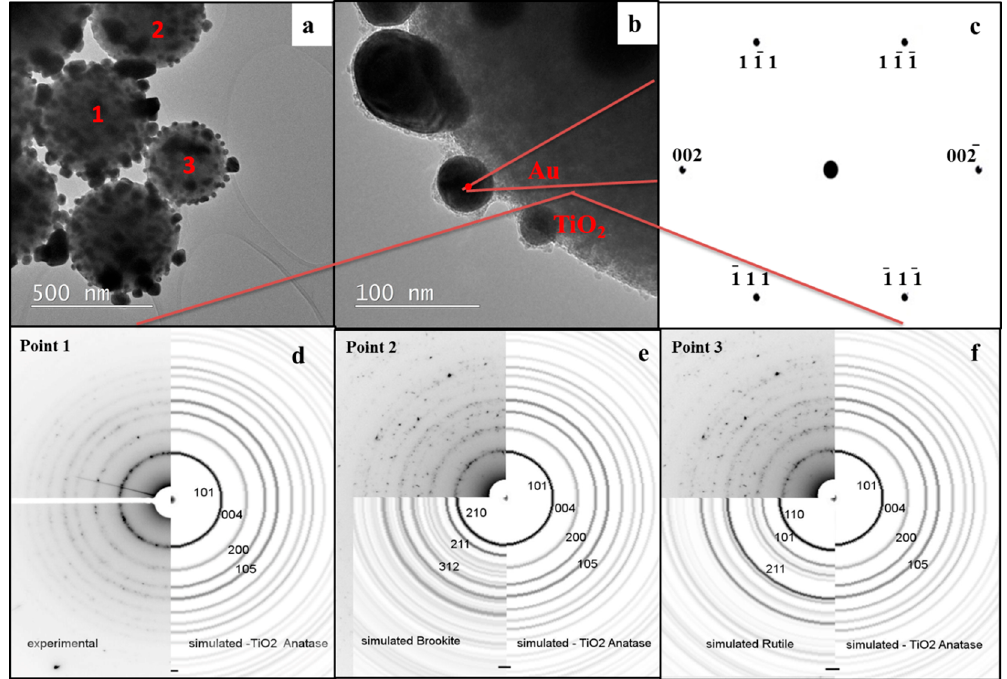
Figure 4. TEM micrographs of Au/TiO 2 powder: ( a ) polygonal (almost spherical) TiO 2 nanoparticle with distributed Au nanoparticles; ( b ) details of Au nanoparticles; ( c ) simulation of the transmission electron diffraction for Au in the [001] TiO 2 plane. Electron diffraction patterns of Au/TiO 2 powder where only a TiO 2 component was analyzed and simulated results for ( d ) anatase; ( e ) anatase and rutile; and ( f ) anatase and brookite.